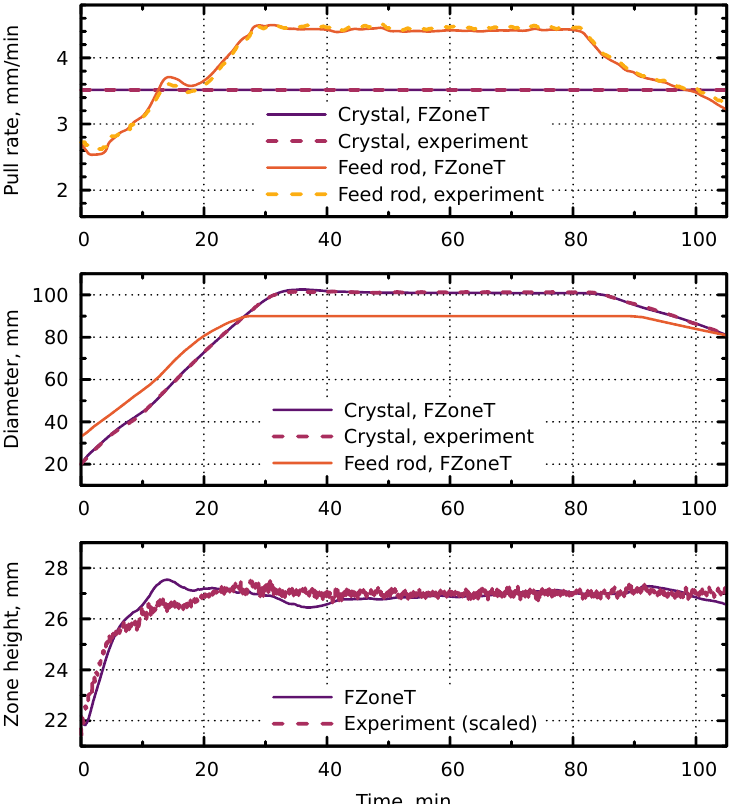
Figure 9. Comparison of transient FZoneT simulation results to the experiment during the entire growth